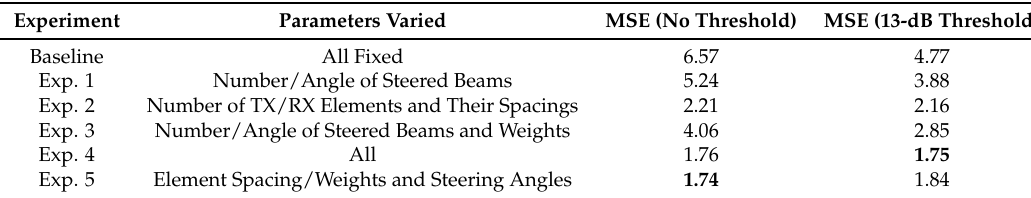
Table 12. Results’